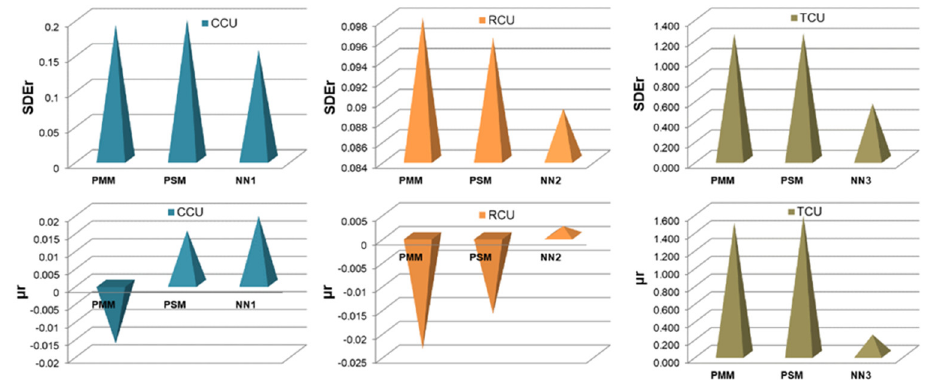
Figure 26. Comparison of fuzzy and ANN modeling results: SDE r and μ r .